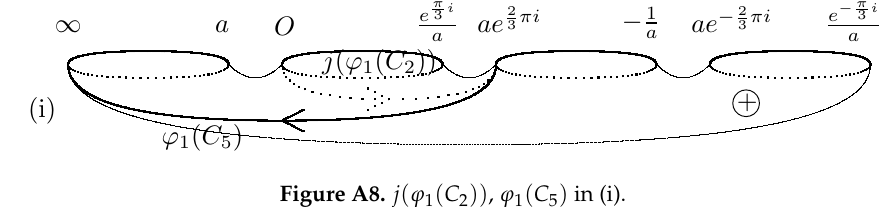
Figure A8. j ( ϕ 1 ( C 2 )) , ϕ 1 ( C 5 ) in (i).